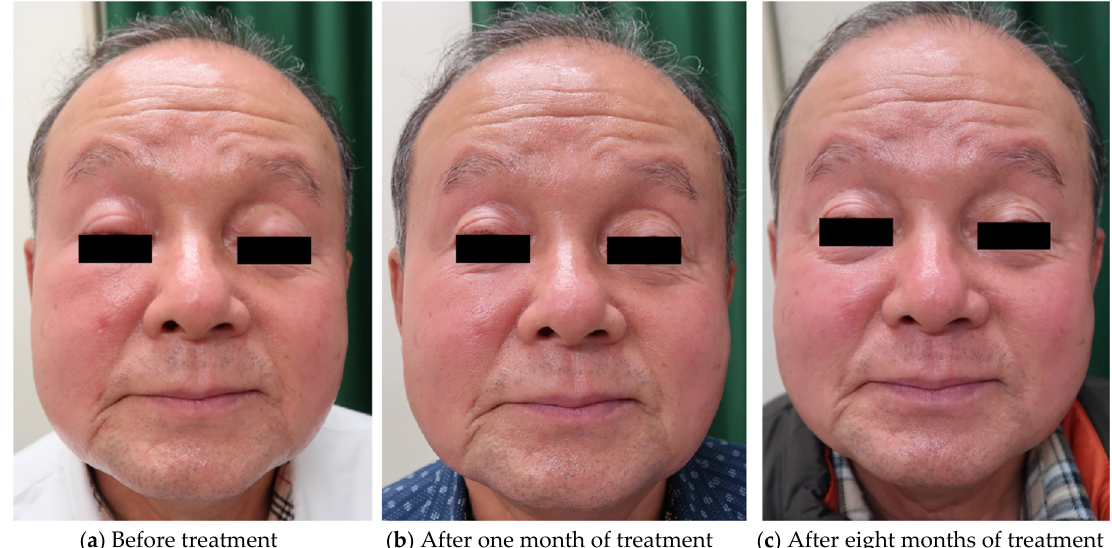
Figure 4. The patient’s right upper eyelid shows a single, erythematous, indurated lesion. His right cheek also shows edematous erythema.